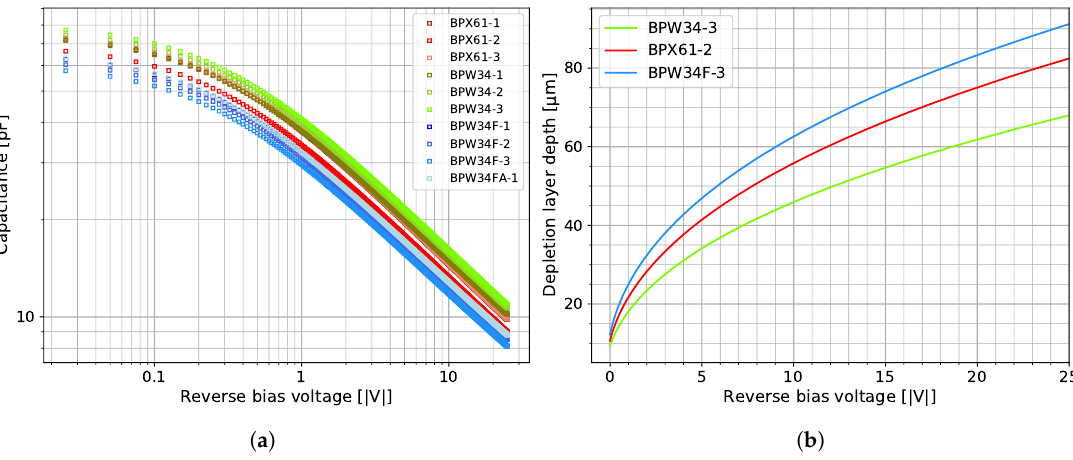
Figure 3. The C-V measurements of 10 diodes (four different variants) shown in ( a ) have been conducted with the Keysight B1500A at 1MHz, 50mV AC amplitude, parallel configuration, at 20 ◦ C, and using a custom-built closed metal fixture. The depletion depth dependance on the reverse bias voltage in ( b ) is based on three of the C-V curves (min, max, and average) by applying Equation